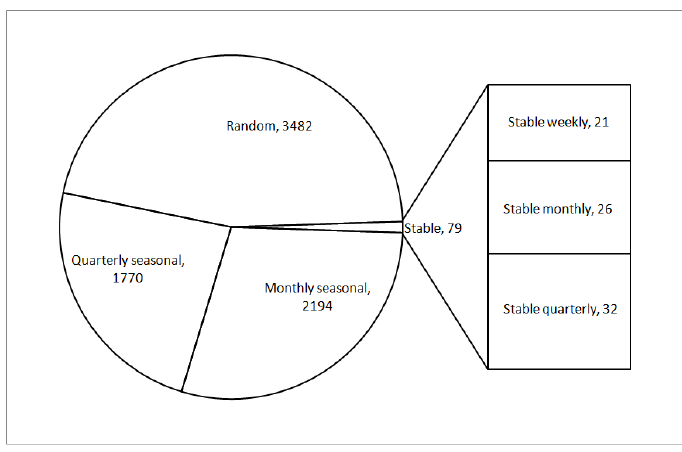
Figure 4. Product distribution in